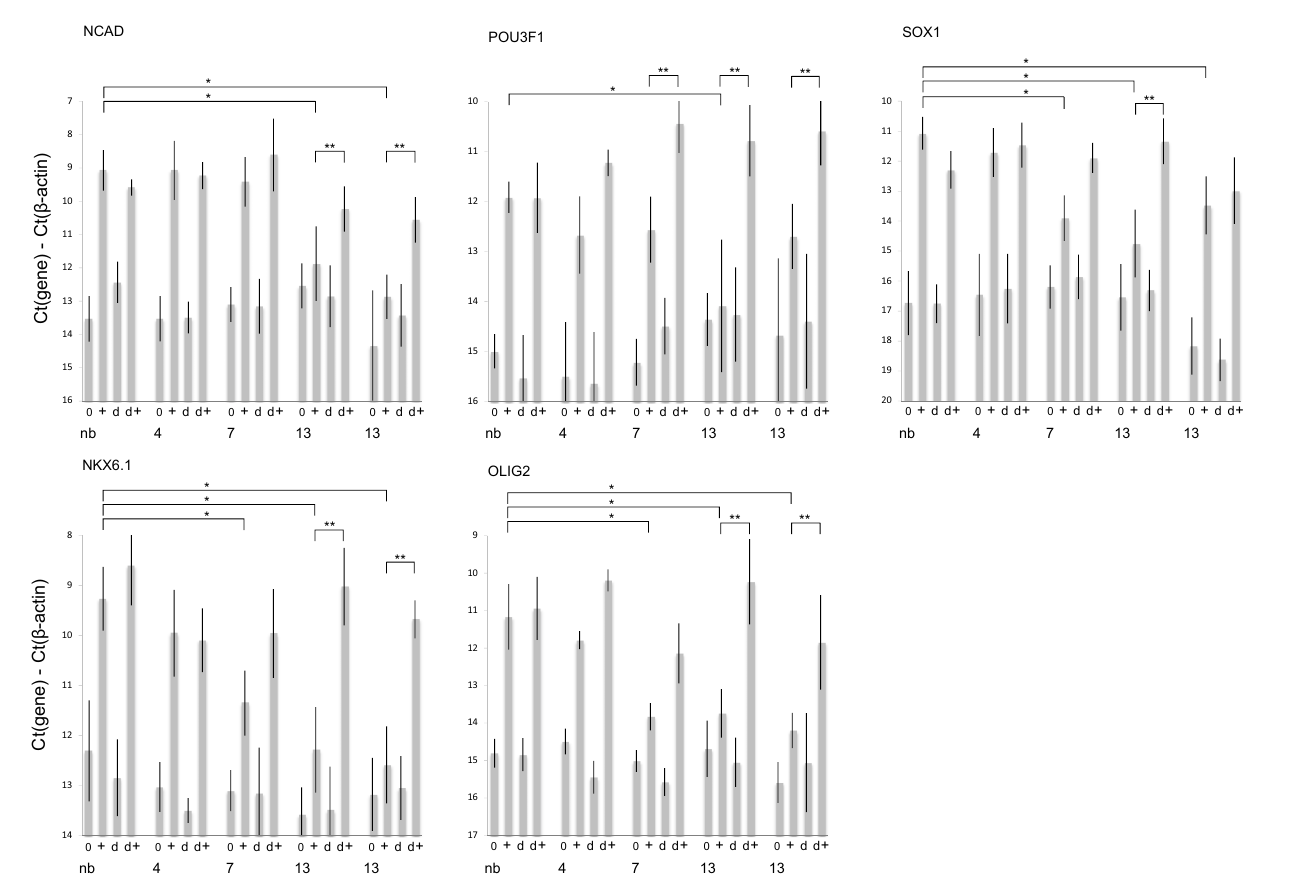
Figure 3. mRNA expression levels for the neural differentiation markers NCAD, POU3F1, SOX1, NKX6.1 and OLIG2 as measured by qPCR. Bars are grouped by marmoset donor ages: newborn (nb), 4 (4 years old), 7 (7 years old) and 13 (each of the two 13-year-olds). Labels along the x axis indicate treatment groups as follows: cells that have not been pretreated with 0.5% DMSO are marked 0 before differentiation and + after the differentiation protocol. Cells that have been pretreated with 0.5% DMSO are marked d before differentiation and d + after the differentiation protocol. A single asterisk indicates that the cells in this group display significantly lower marker expression ( p < 0.05 one-way ANOVA followed by Dunnett’s test) than newborn controls that were subjected to the differentiation protocol but not pretreated with DMSO. A double asterisk indicates that the cells in this group, when differentiated after pretreatment with DMSO, display significantly increased marker expression ( p < 0 . 05 one-way ANOVA followed by Dunnett’s test) when compared with their same-age controls that were not pretreated with DMSO. Each directed differentiation was replicated three times per clone and averaged (bars for nb, 4 and 7: n = 3; three clones were generated for each 13-year-old animal; bars for both animals: n =